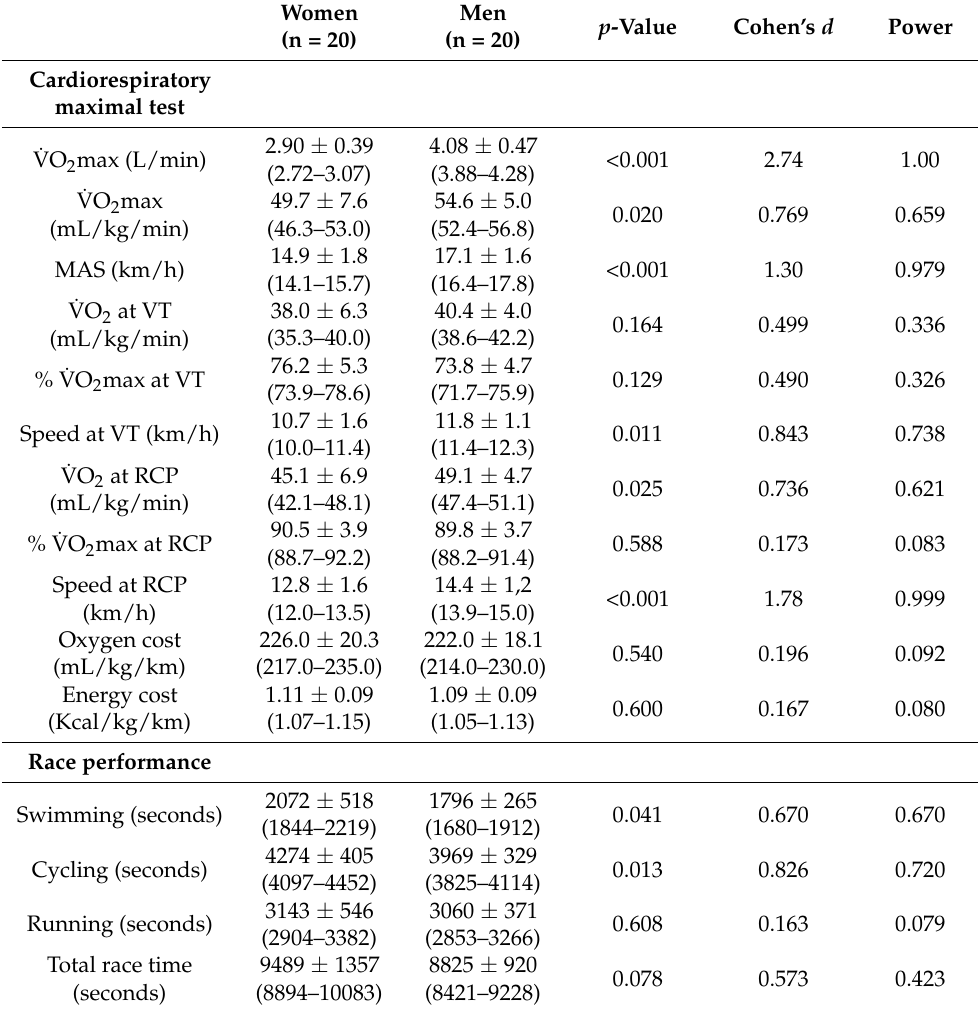
Table 2. Measured variables in the cardiorespiratory maximal test and performance for each